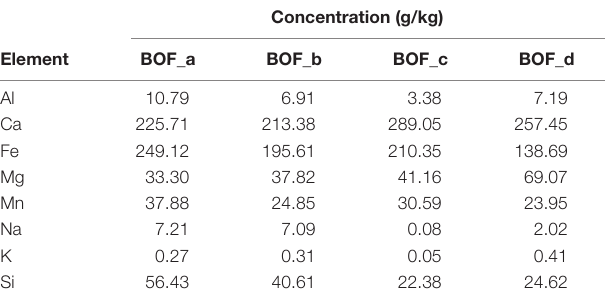
TaBle 1 | Major element composition of the BOF